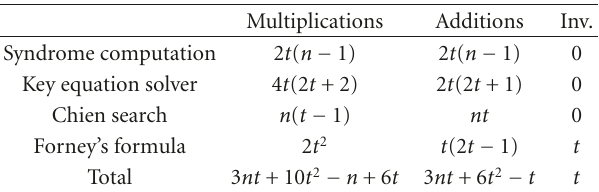
Table 2: Direct implementation complexity of